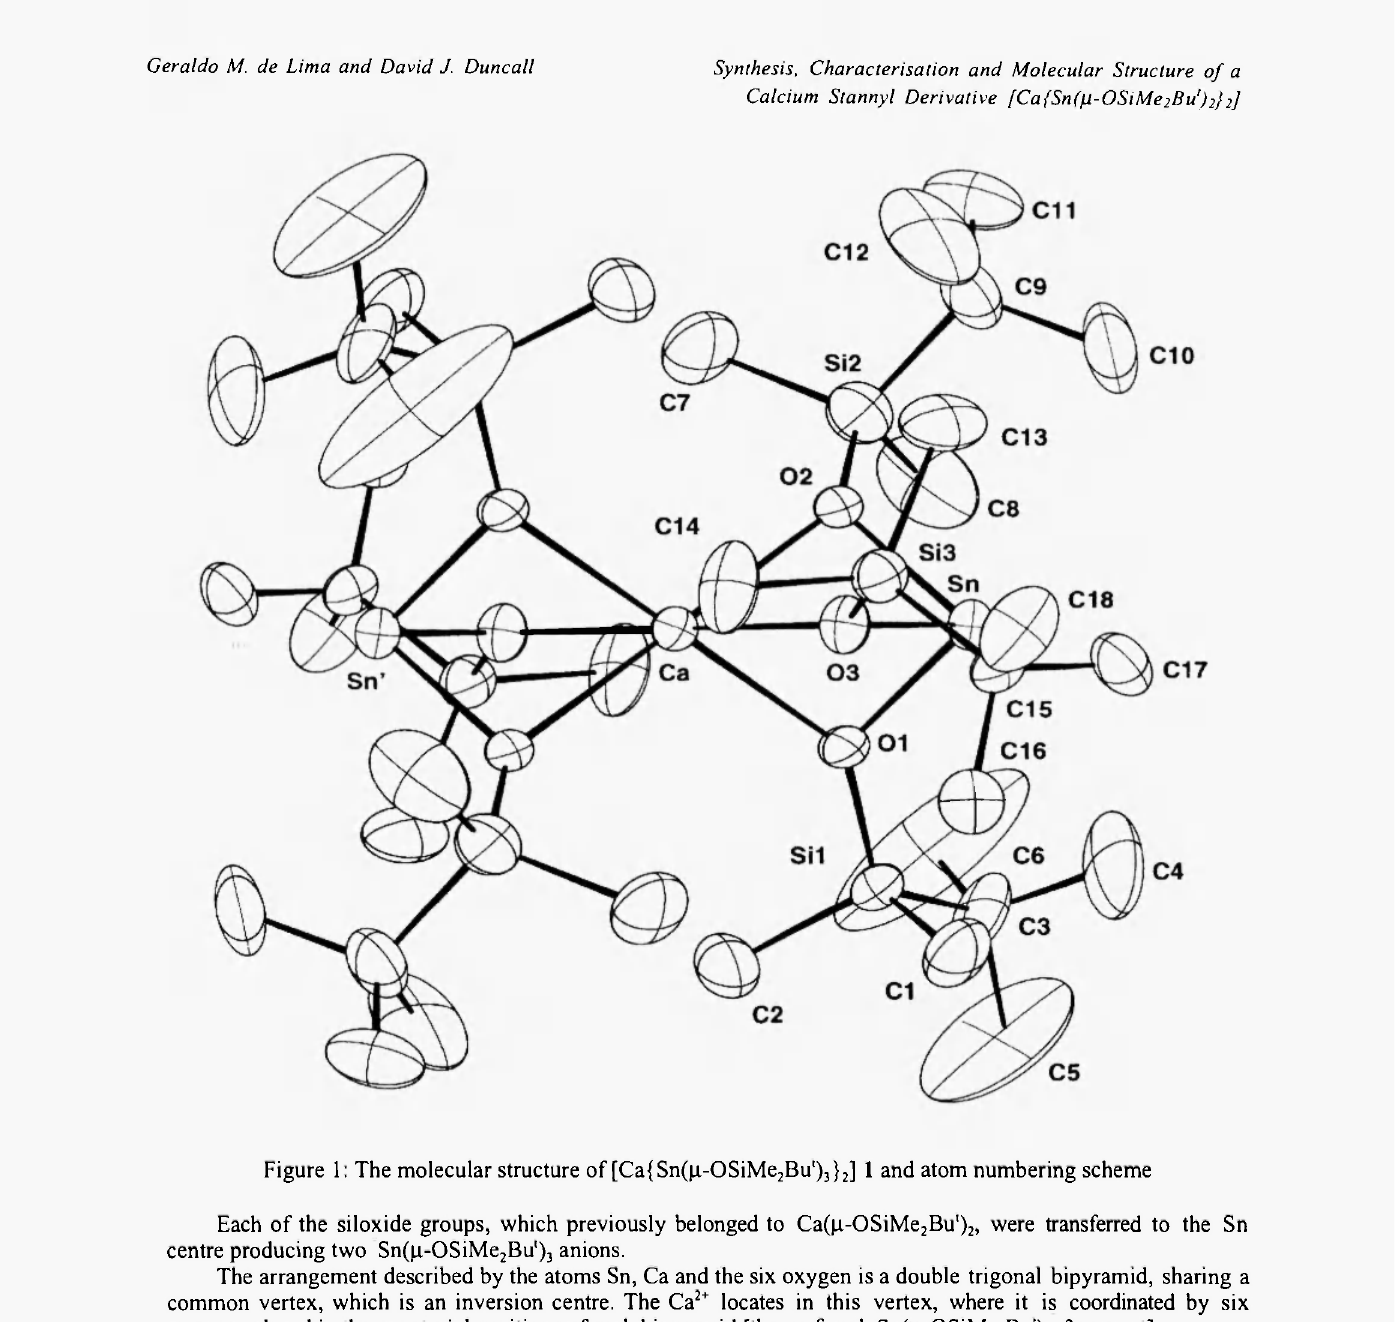
Figure 1: The molecular structure of [Ca{Sn^-OSiMe 2 Bu') 3 } 2 ] 1 and atom numbering